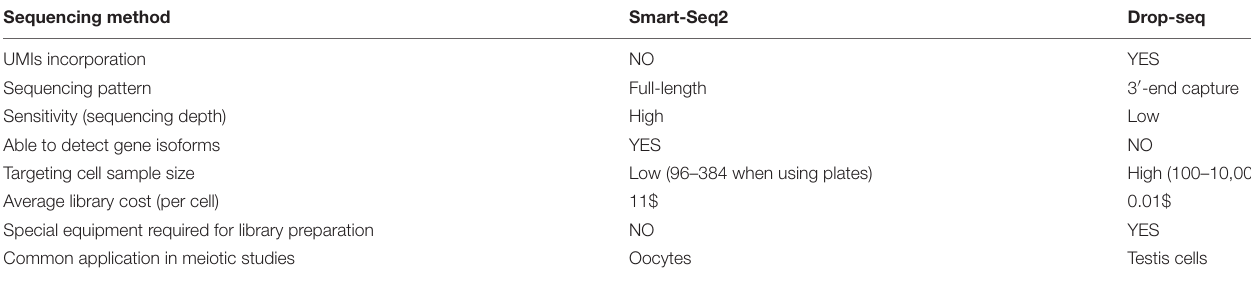
TABLE 1 | Comparison between Smart-Seq2 and Drop-seq in meiosis studies. Sequencing